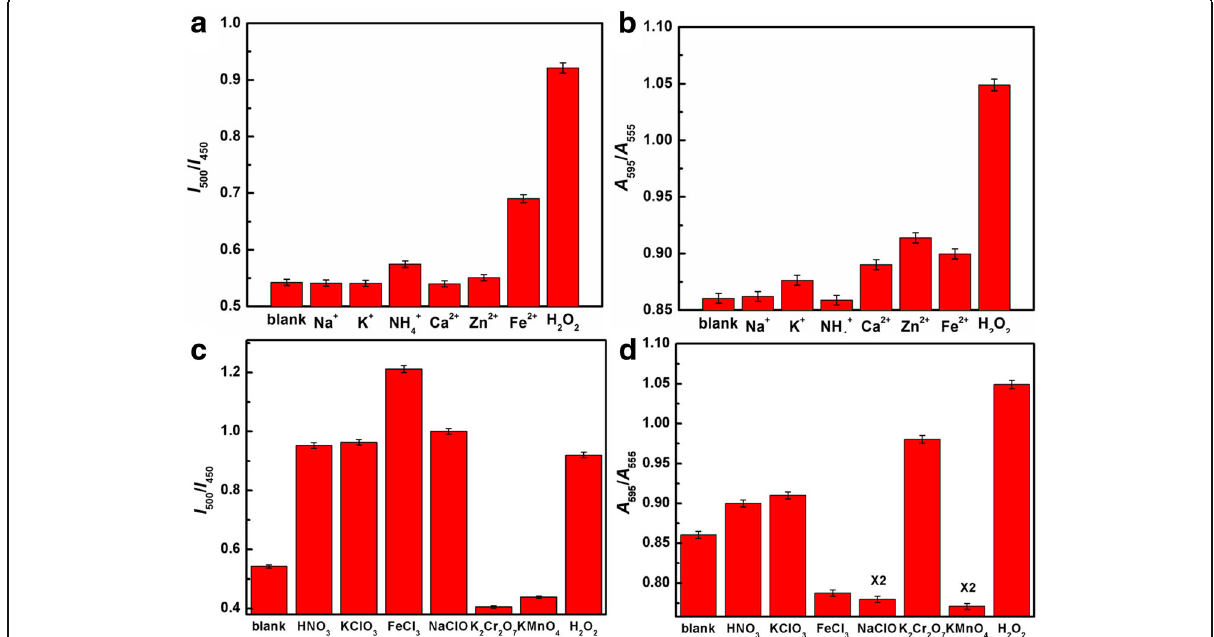
Fig. 5 a , c Fluorescence ratio I 500 / I 450 of solution containing CDs and various interferent cations ( a ) and oxidants ( c ). b , d Absorption ratio A 595 / A 555 of solution containing CDs and various interferent cations ( b ) and oxidants ( d )